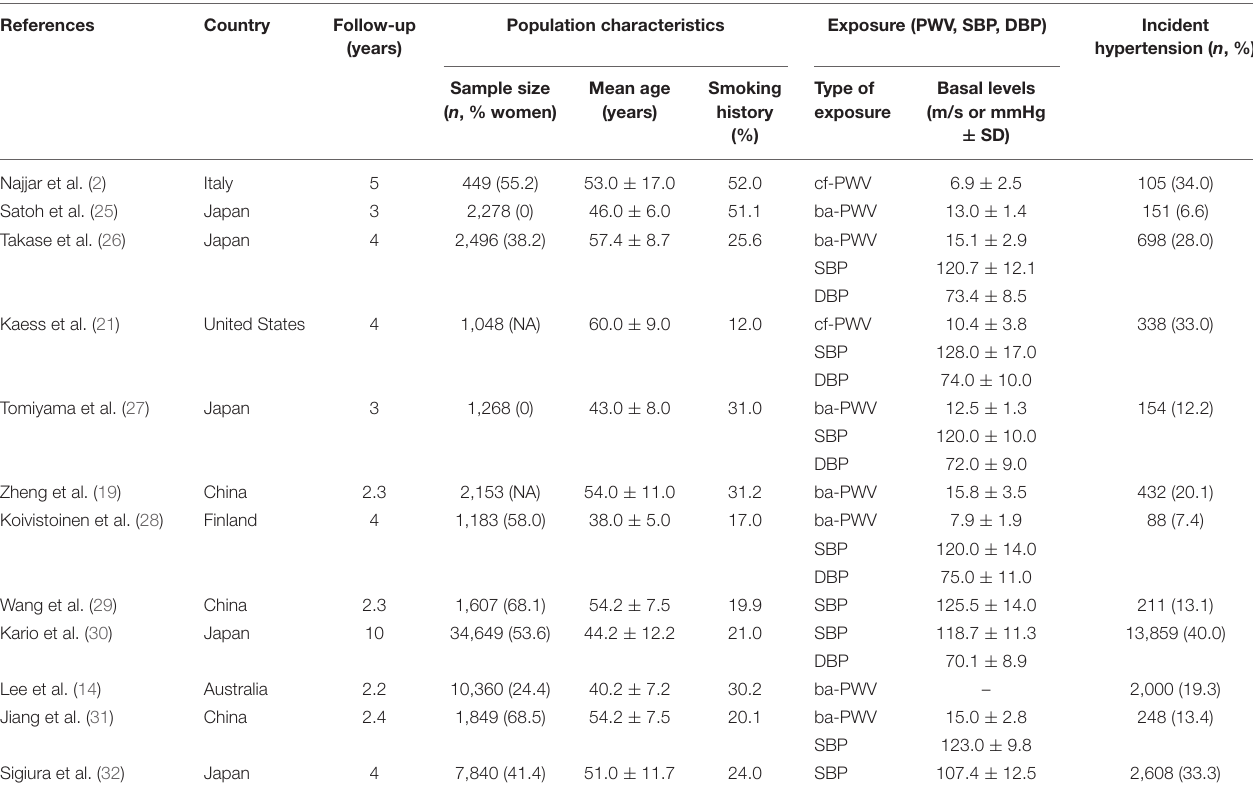
TABLE 1 | Characteristics of the included